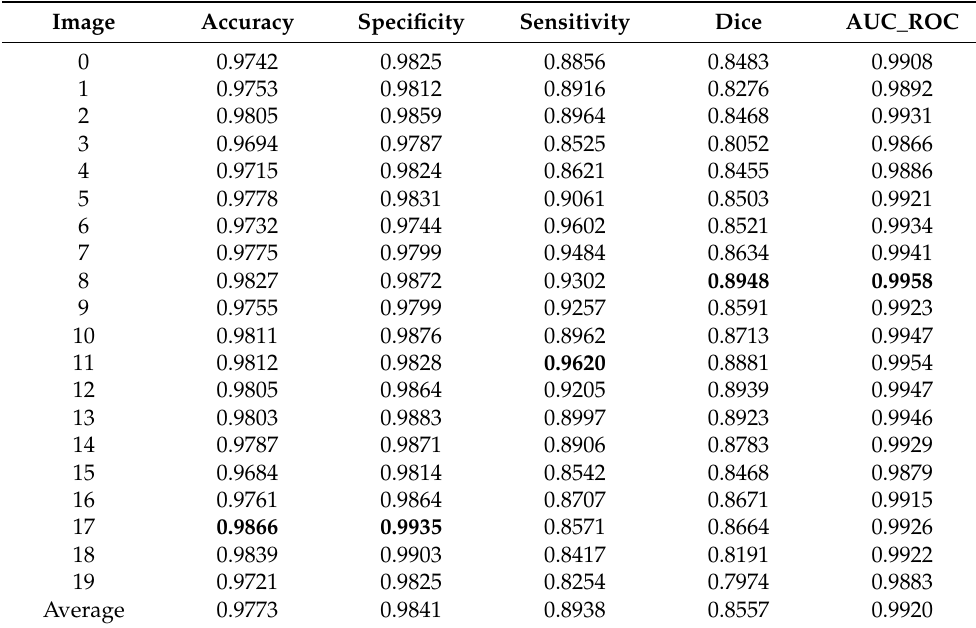
Table 3. Test results on STARE dataset using the leave-one-out method.